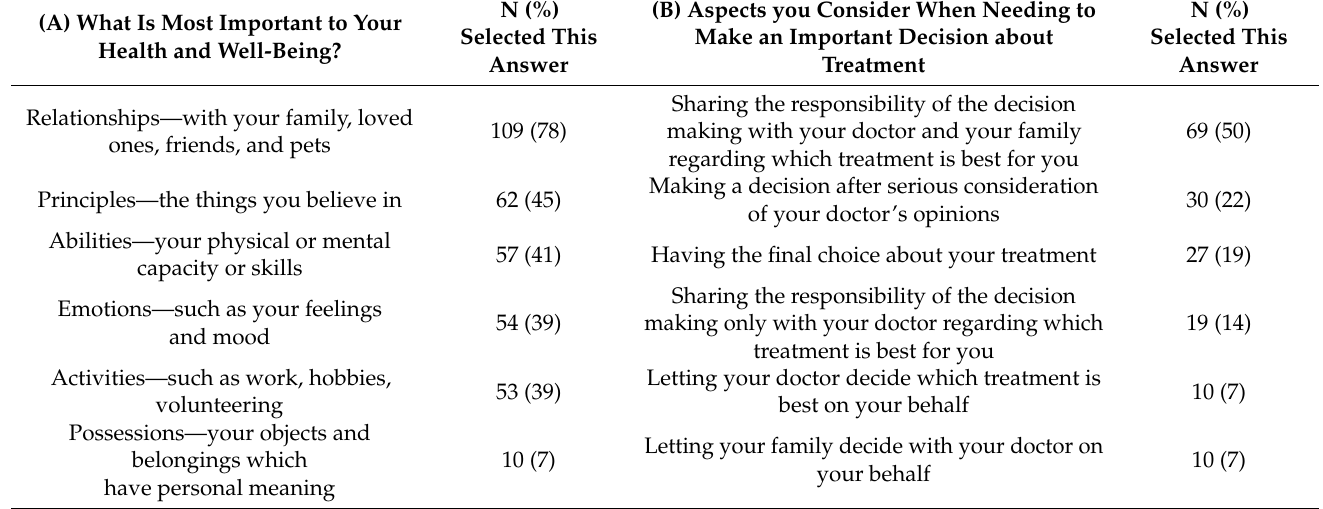
Table 2. Domains on well-being and treatment decisions for all respondents (N = 139) *.